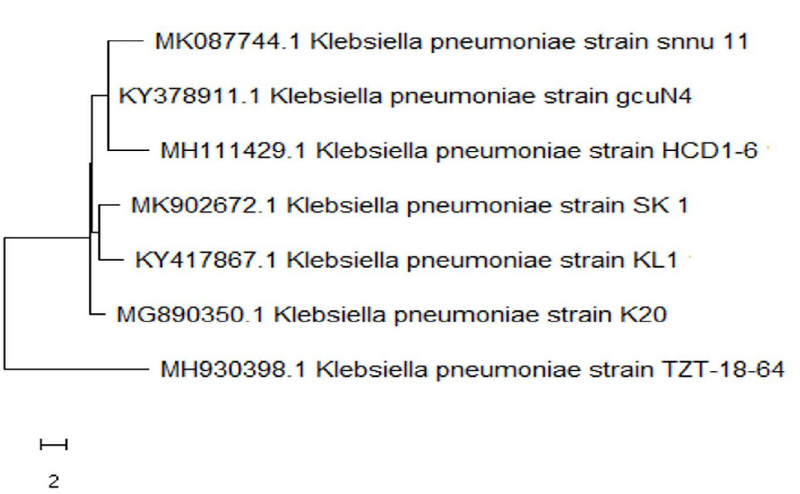
Fig. 1. Phylogenetic tree derived from 16S rRNA gene sequence of Klebsiella pneumoniae SK1 (MK902672.1), using neighbor joining program in MEGA